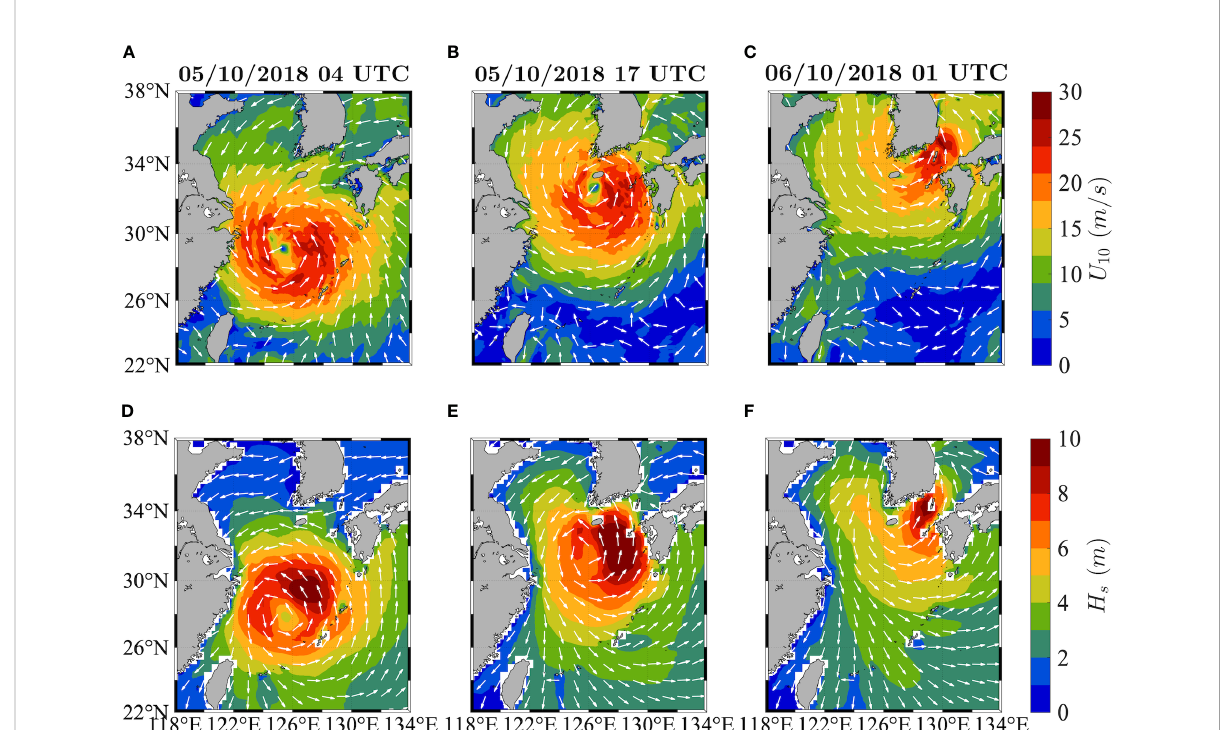
FIGURE 1 (A – C) Wind speed U 10 (coloured shading ) and mean wind direction (arrows, decimated for graphical purposes) fi elds and (D – F) signi fi cant wave height H s (coloured shading ) and mean wave direction (arrows, decimated for graphical purposes) fi elds in the East China Sea and the Yellow Sea during the tropical storm Kong-rey on 5 October 2018 at 04 (left) and 17 UTC (centre) and on 6 October 2018 at 01 UTC